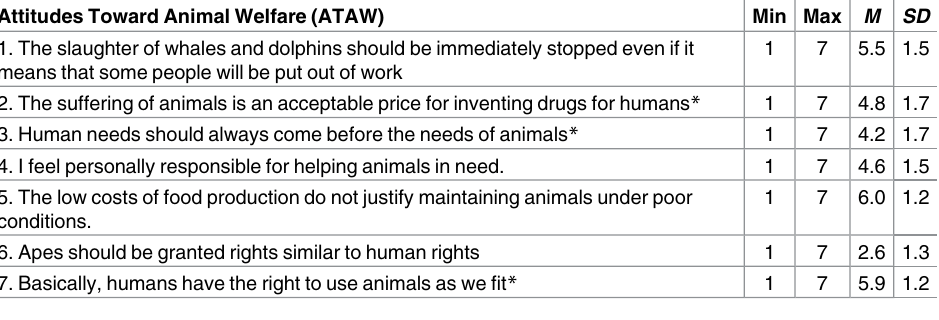
Table 1. Descriptive statistics for each of the ATAW scale